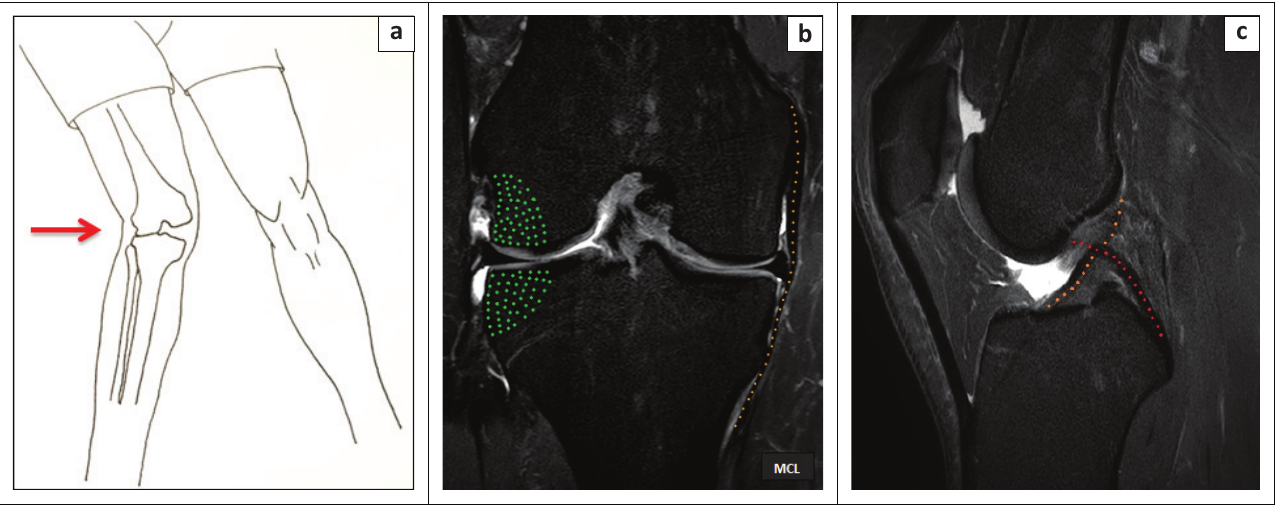
FIGURE 4: Pure valgus: (a) Schematic depicts medially directed force, (b) right knee lateral tibia, and lateral femoral condyle impactions, with medial collateral ligament injury, and (c) anterior cruciate ligament or posterior cruciate ligament injury may be present depending on severity of